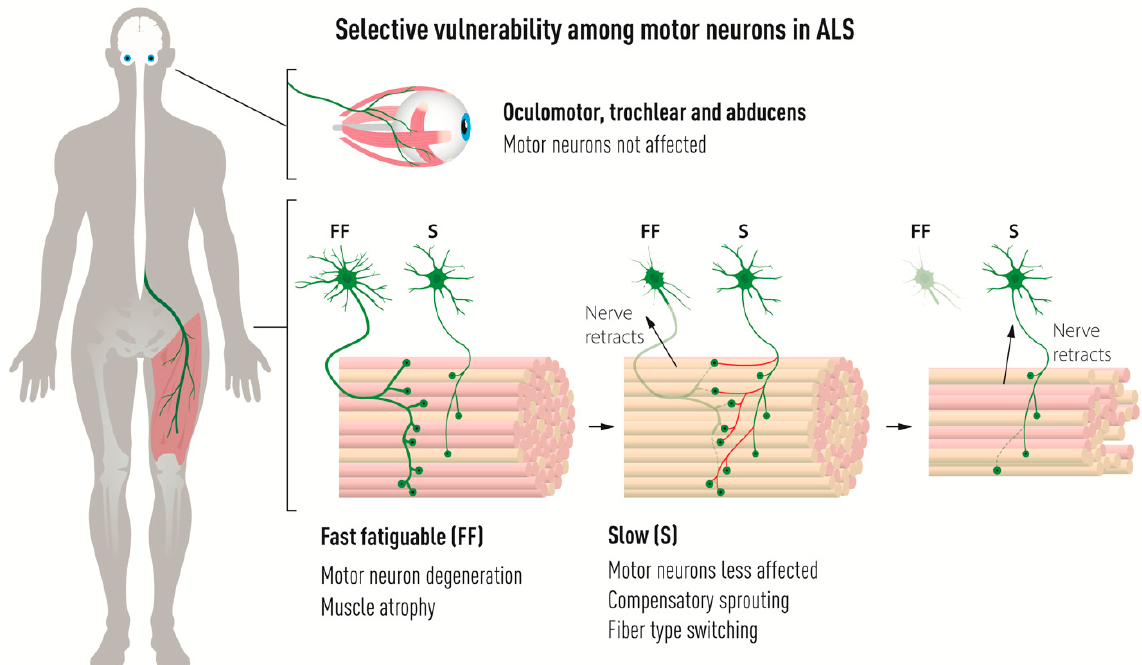
Figure 4. Selective vulnerability among somatic motor neurons in ALS. In ALS, somatic motor neurons of cranial motor neurons of the oculomotor, trochlear, and abducens nuclei, which regulate eye movement, remain unaffected until the end-stage of the disease. Among spinal motor neurons, there is a differential vulnerability with fast fatigable (FF) motor neurons being highly vulnerable and degenerating before symptoms onset, with resulting muscle atrophy. Slow (S) motor neurons are affected later in the disease and compensate for the loss of FF motor neurons by sprouting and innervating vacated endplates that were previously occupied by FF motor neurons. This results in fiber type switching of muscle from fast to slow. Eventually, S motor neurons are also affected and their NMJs with muscle are disrupted and their axons retract from muscle with resulting muscle weakness and atrophy.